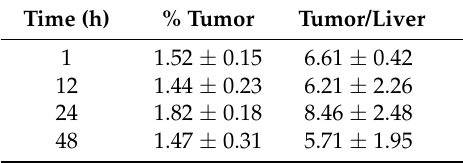
Table 1. Nimotuzumab uptake in tumor tissue and uptake ratio between tumor and liver tissues.